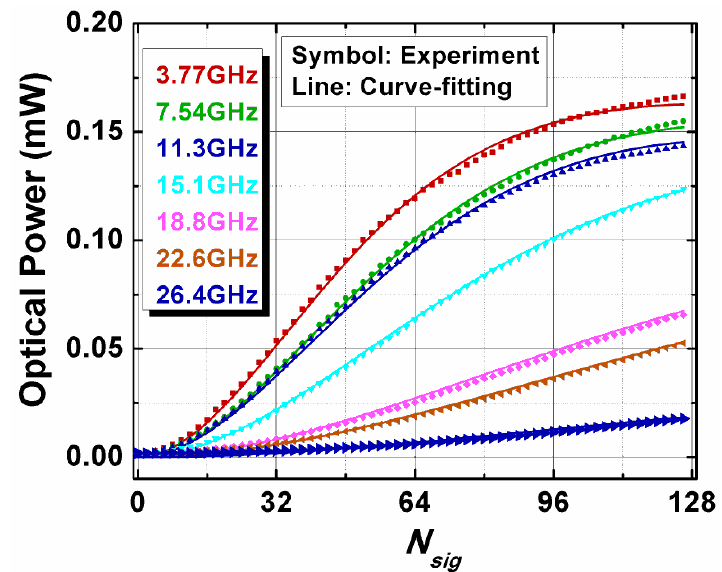
Figure 3. Results over different frequencies. Measurement results agree well with the theoretical analysis.